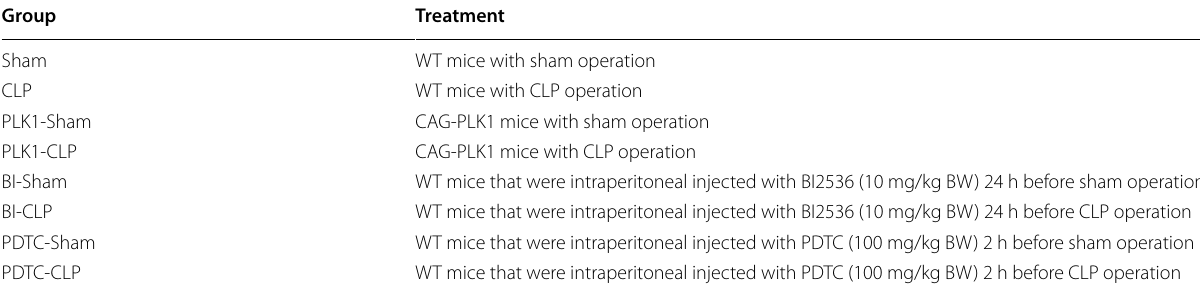
Table 1 Experimental treatments and groupings of the mice Group